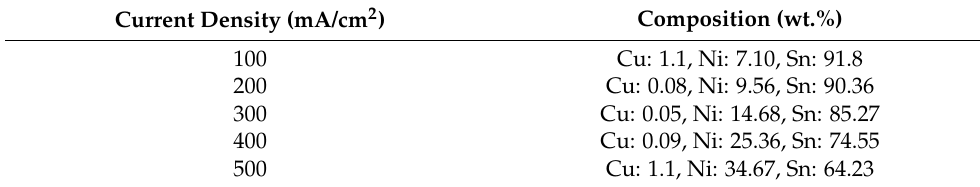
Table 3. Compositional analysis of Sn-plated Ni/Cu coatings.